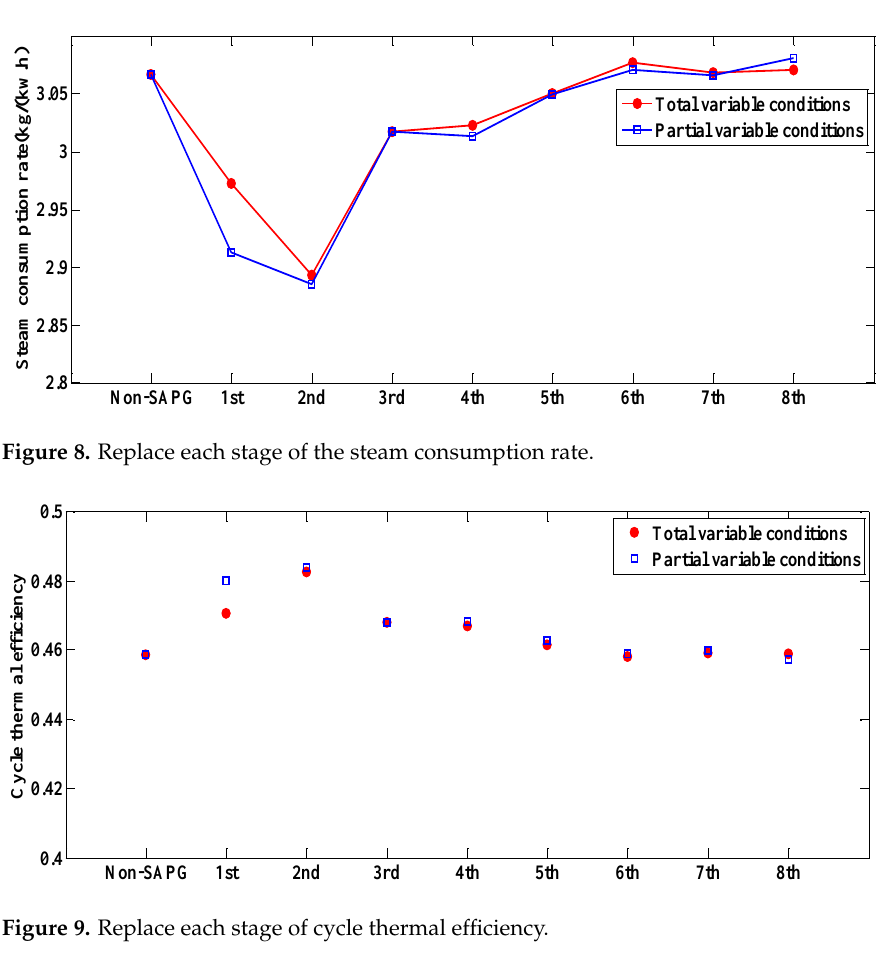
Figure 7. Replace each stage of the heat consumption rate.